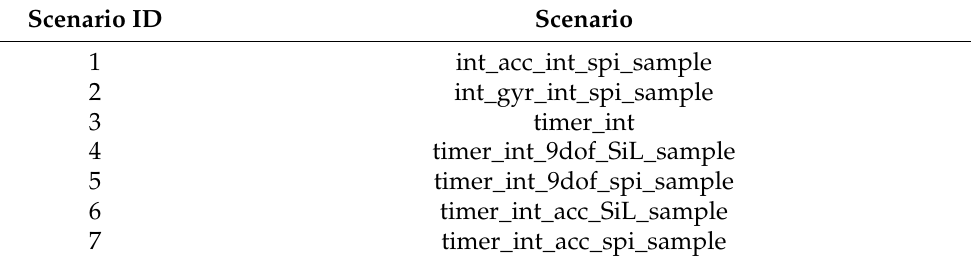
Table 2. Measured test scenarios of sampling sensor